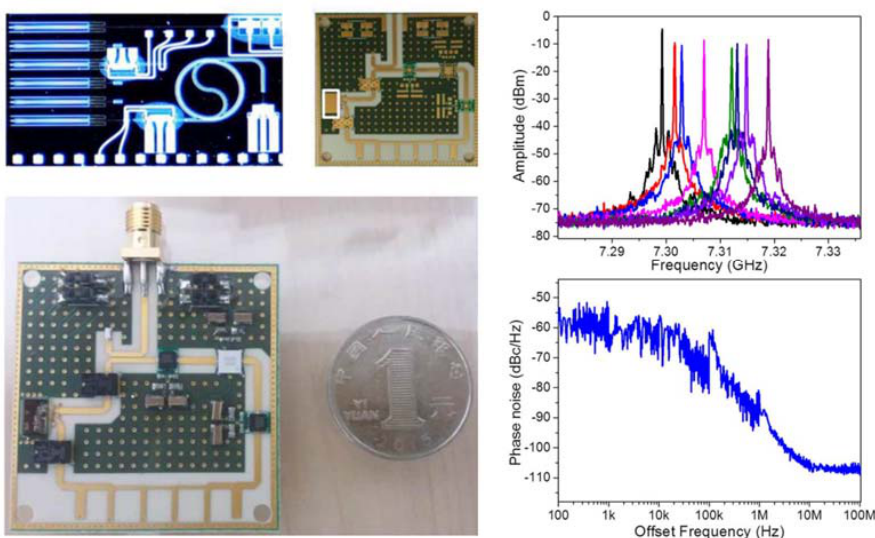
Figure 9. The integrated OEO. The frequency tunability of the OEO is around 20 MHz, with a central oscillation frequency of 7.3 GHz [38]. Reprinted with permission from Reference [38]. Copyright 2017 IEEE.